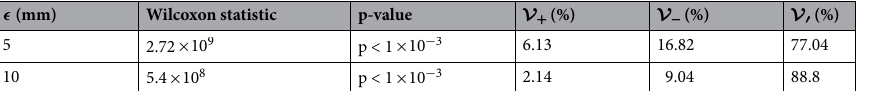
Table 2. Statistical significance of Fig. 10. Parameter V + represents percentage of domain volume that has (cid:31) T ≥ 1 ◦ C. Parameter V − represents percentage of domain volume that has (cid:31) T ≤ − 1 ◦ C. Parameter V 0 represents percentage of domain volume that has − 1 ◦ C < � T < 1 ◦ C.